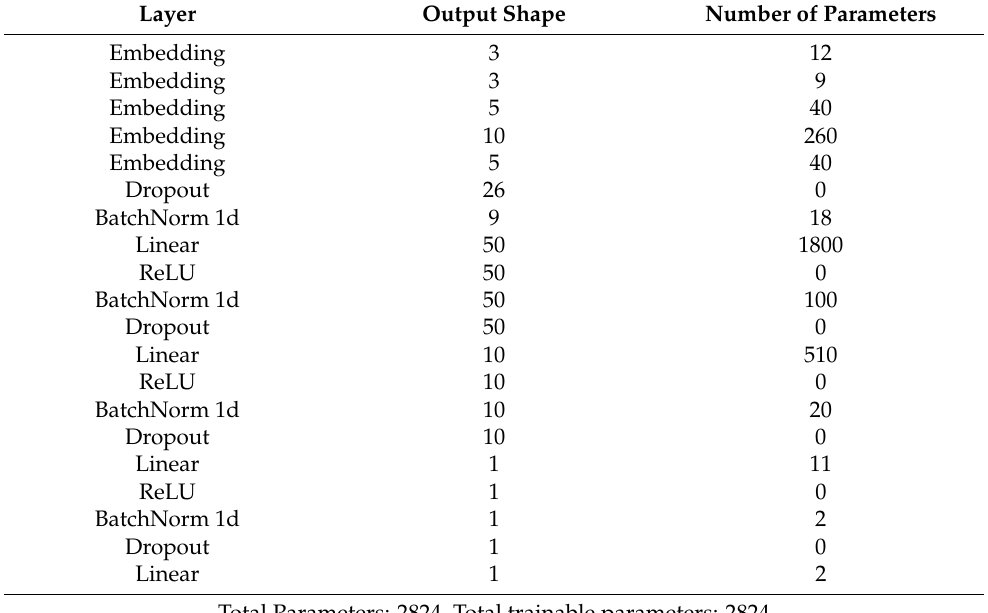
Table 2. The layer structure of the model